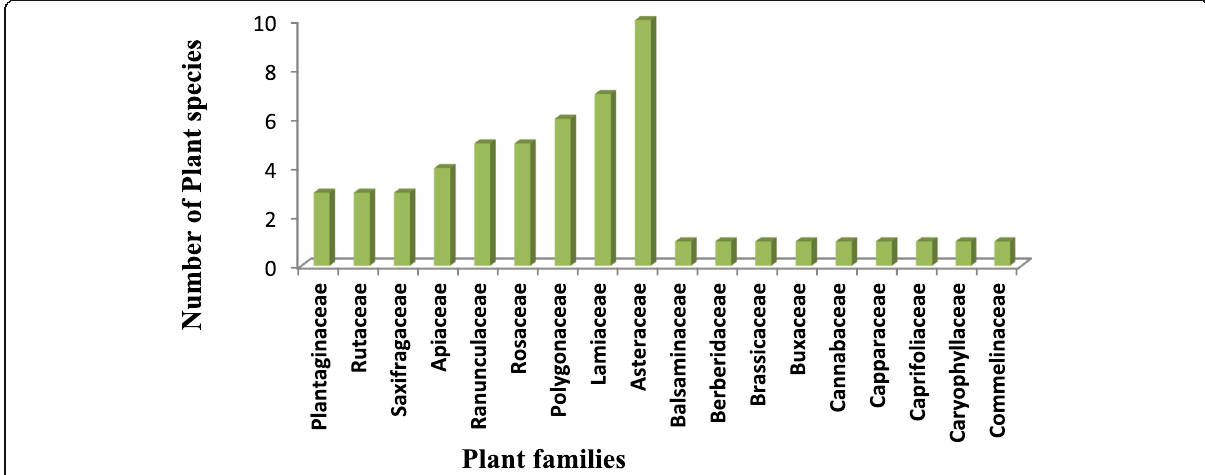
Fig. 2 Dominant families of medicinal plants utilized for skin disorders in Northern